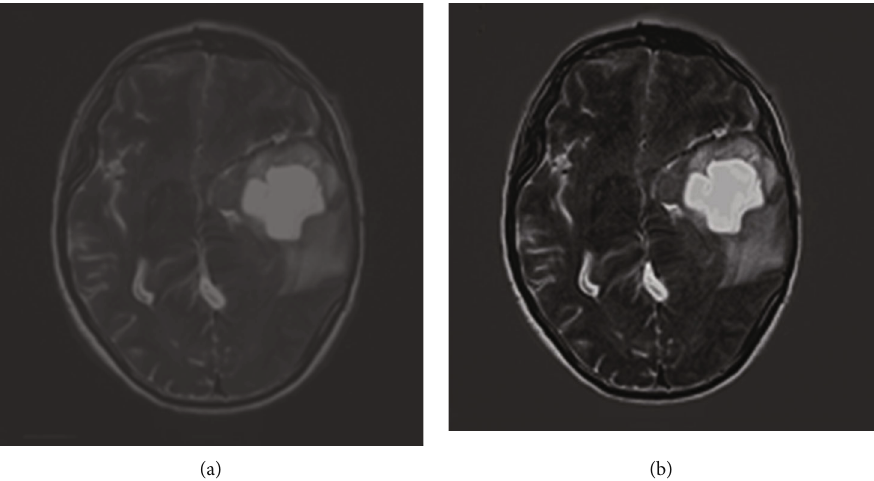
Figure 1: Images before and after processing. (1(a) MRI image before processing; 1(b) MRI image after processing).